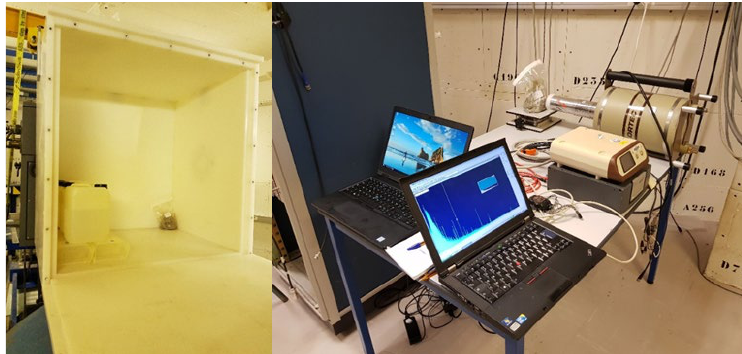
Fig. 7. Neutron energy spectra for two electron energies (MCNP6 simulation results) [5].